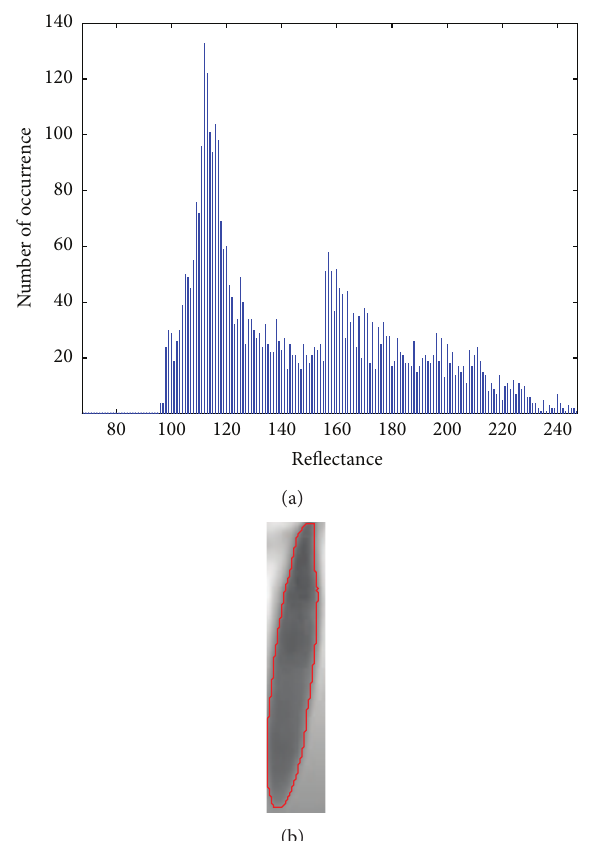
Figure 14: (a) Histogram of the reflectance image. (b) Estimated reflectance image and the boundary of the vocal folds obtained by thresholding with 𝑇 = 150 (reflectance is scaled by 255 for grayscale